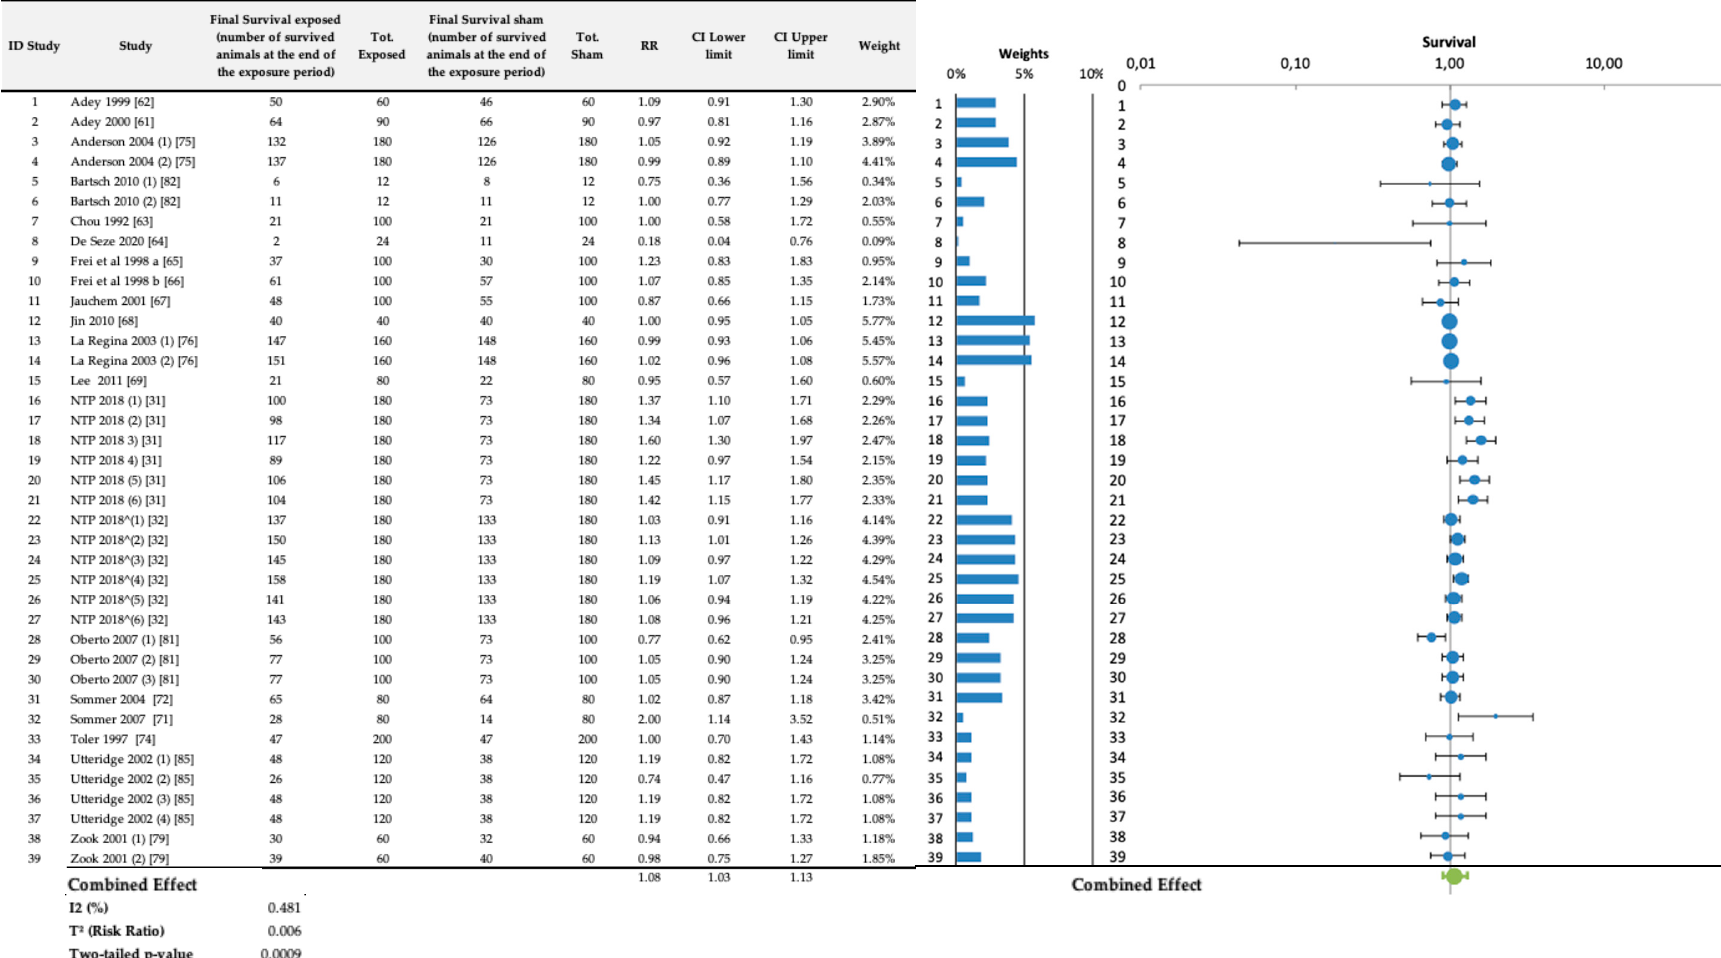
Figure 8. Survival analysis results deriving from the data extracted from the selected carcinogenesis studies (NTP 2018^ identifies the NTP mice study).